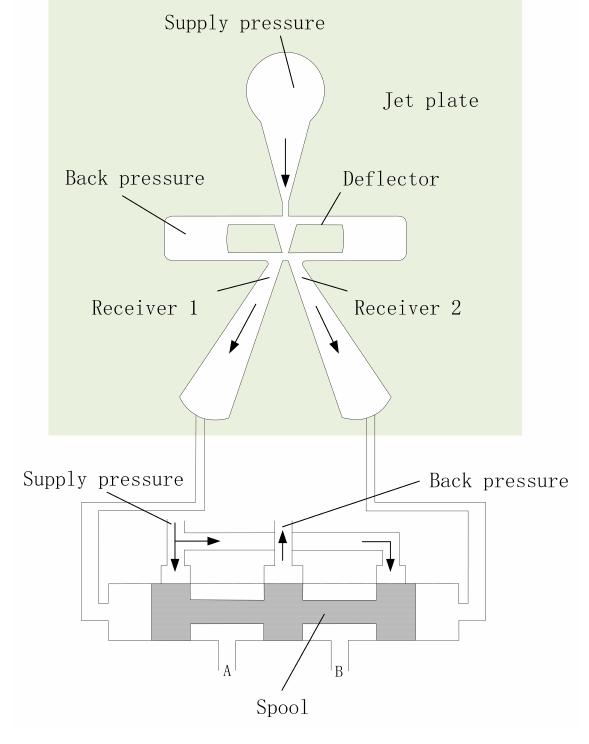
Figure 1. Hydraulic amplifier.